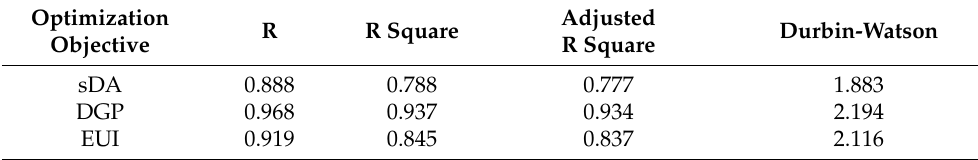
Table 10. No shading SAS design parameters linear regression model.